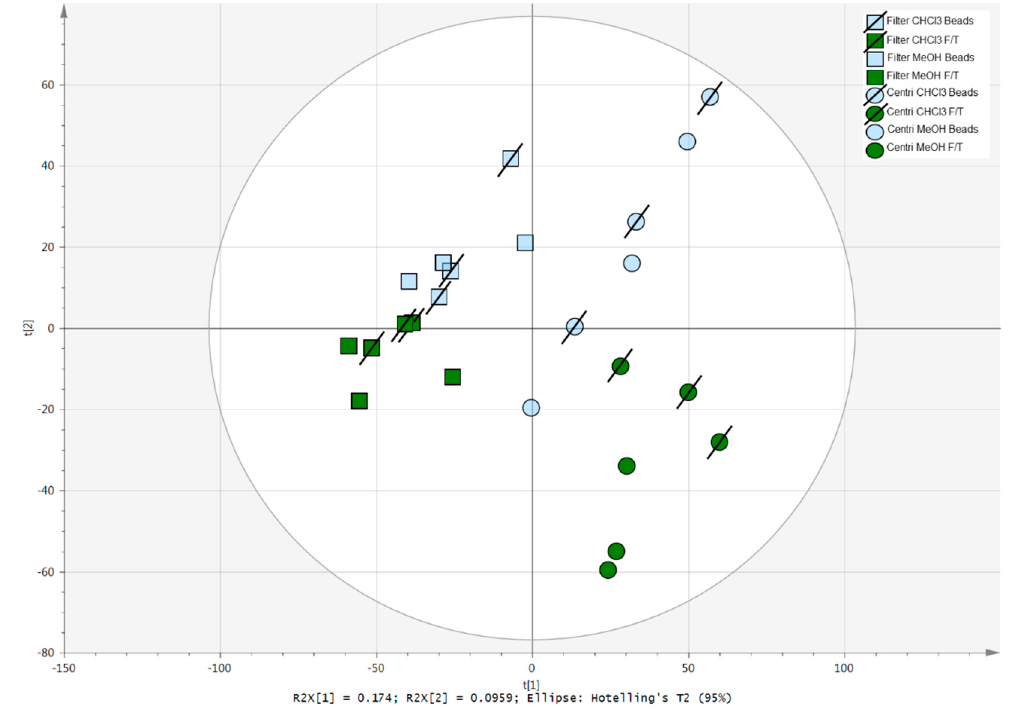
Figure 3. Principal component analysis (PCA) score plot of the eight sample preparation procedures evaluated in triplicates.